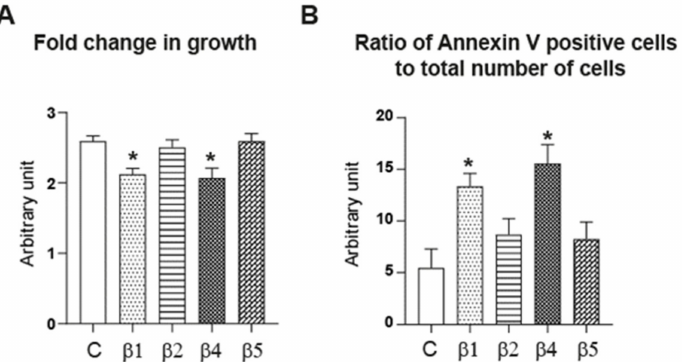
Figure 5. Contrary to ER β 5 and ER β 2, both ER β 1 and ER β 4 promote HGrC1 cell apoptosis. HGrC1 were transiently and efficiently (~70%) transfected by nucleofection with either Flag (C), Flag-ER β 1 ( β 1), Flag-ER β 2 ( β 2), Flag-ER β 4 ( β 4), or Flag-ER β 5 ( β 5). ( A ) MTT assay was performed 24 h and 48 h post-transfection. The quantity of formazan, which is directly proportional to the number of viable cells, was measured by recording changes in absorbance at 575 nm. Fold change in growth was expressed as the ratio of the OD 575nm value at 48 h post-transfection onto that measured at 24 h post-transfection. Contrary to Flag-ER β 5 ( β 5) or Flag-ER β 2 ( β 2), Flag-ER β 4 ( β 4) as well as Flag-ER β 1 ( β 1) significantly reduced the fold change in cell growth. Each experiment was performed 3-6 times, and data are reported as means ± SEM from four replicates. * p ≤ 0.05 vs. control Flag (C) by the Mann–Whitney test. ( B ) Twenty-four hours post-transfection, annexin V cell binding was assessed followed by measurement of the total cell number. Values represent the ratio between annexin V binding to the total cell number. Contrary to Flag-ER β 5 ( β 5) or Flag-ER β 2 ( β 2), Flag-ER β 4 ( β 4) as well as Flag-ER β 1 ( β 1) significantly increased cell apoptosis. Means ± SEM in four replicates performed 3–6 times * p ≤ 0.05 vs. control Flag (C) by the Mann–Whitney